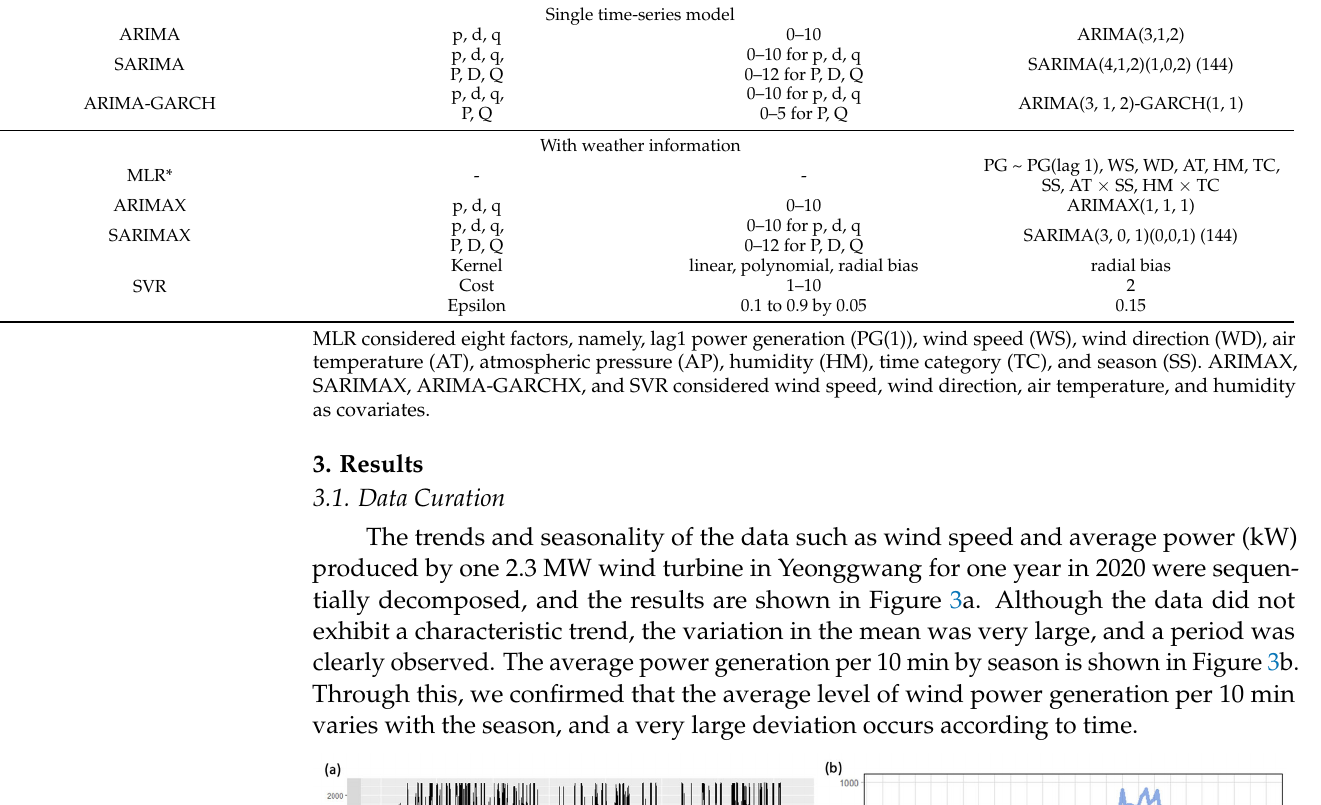
with artificially limited output should be excluded before developing the models.